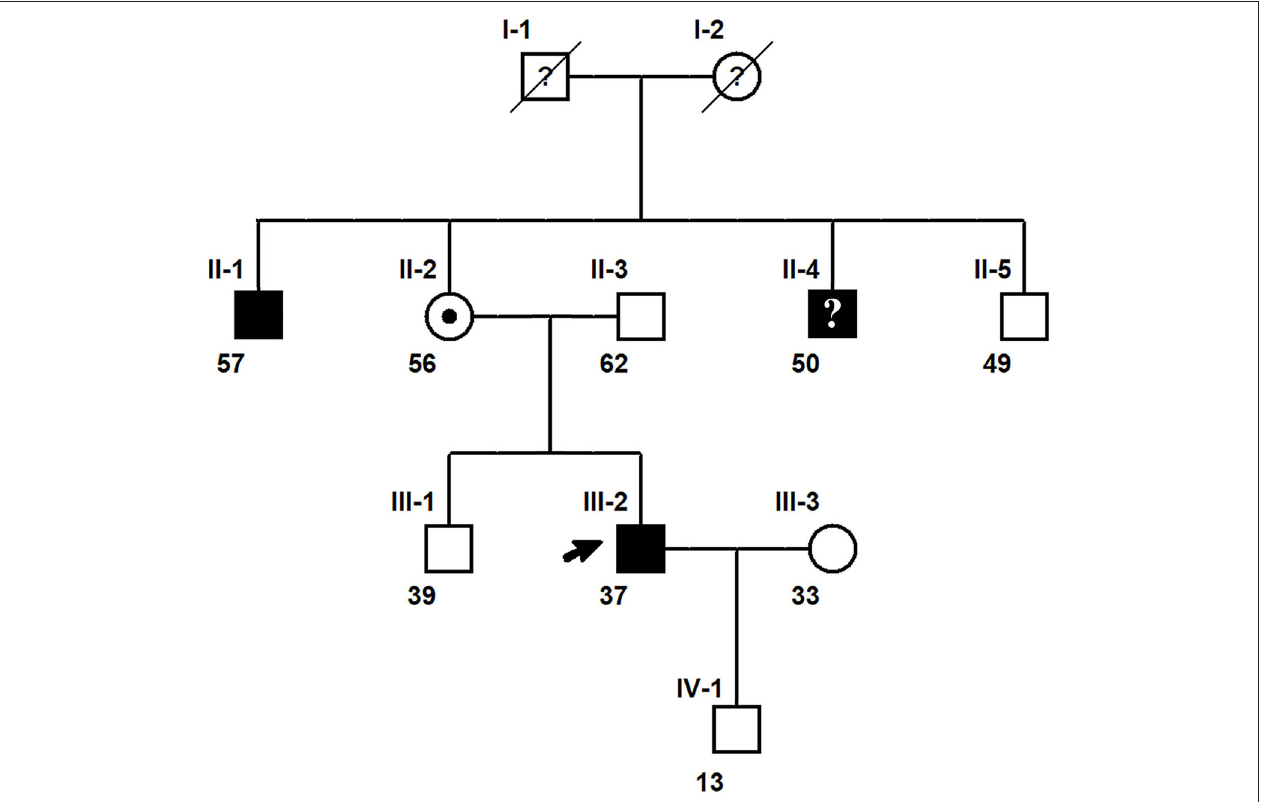
FIGURE 1 | A three-generation pedigree chart of the proband with the SYN1 mutation. Squares represent males, and circles denote females. Individuals with the SYN1 mutation are represented with a shaded symbol while unaffected individuals are denoted with unshaded symbols. Roman numerals I, II, and II above each node indicate the generation while the numbers denote the number of individuals in each generation. The numbers at the bottom left of each node indicate the age of each individual. Individuals with unknown clinical diagnosis or uncertain diagnosis are denoted by a question mark (?) within the symbol. A slash through a symbol represents a deceased individual. The proband with the SYN1 hemizygous c.1807C > T (p.Q603Ter) mutation is indicated with a black arrow. Individual II-4 has the SYN1 mutation but did not experience RE. The proband’s mother (circle with a dot) is a carrier of the mutant SYN1